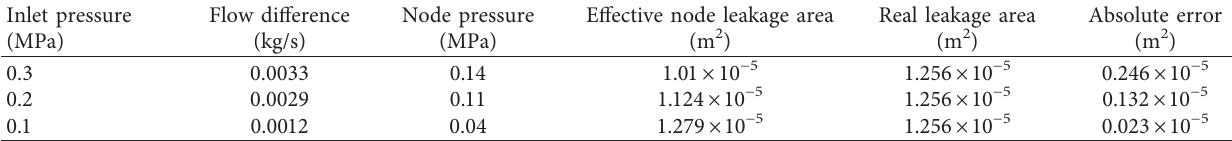
Table 1: The first test of X 5 node leakage parameters under different pressures.